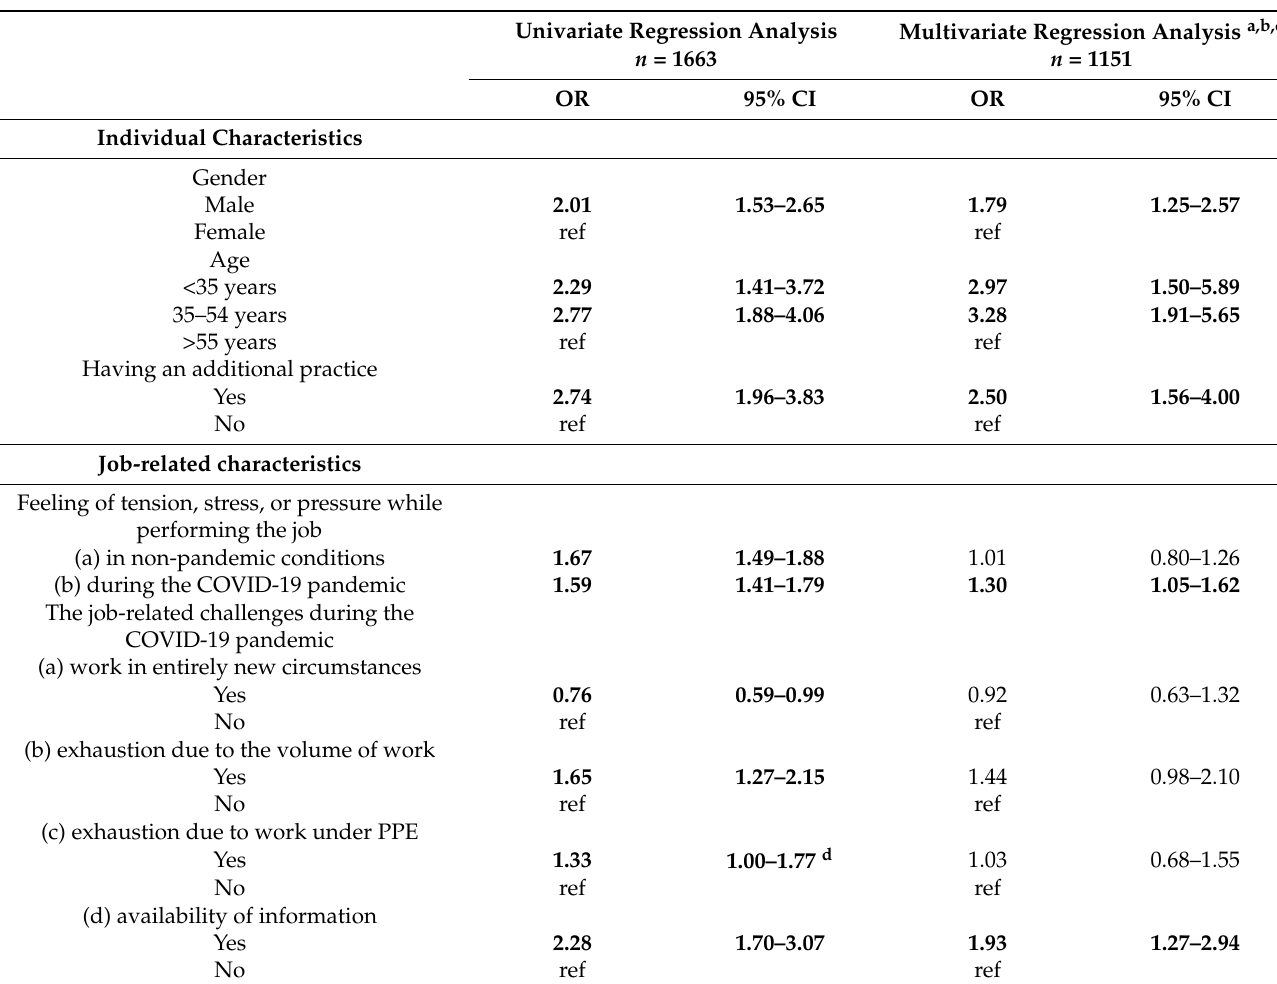
Table 3. Potential predictors of the intention to leave a current job within the next five years among public health workers from 25 public health institutes, Serbia,